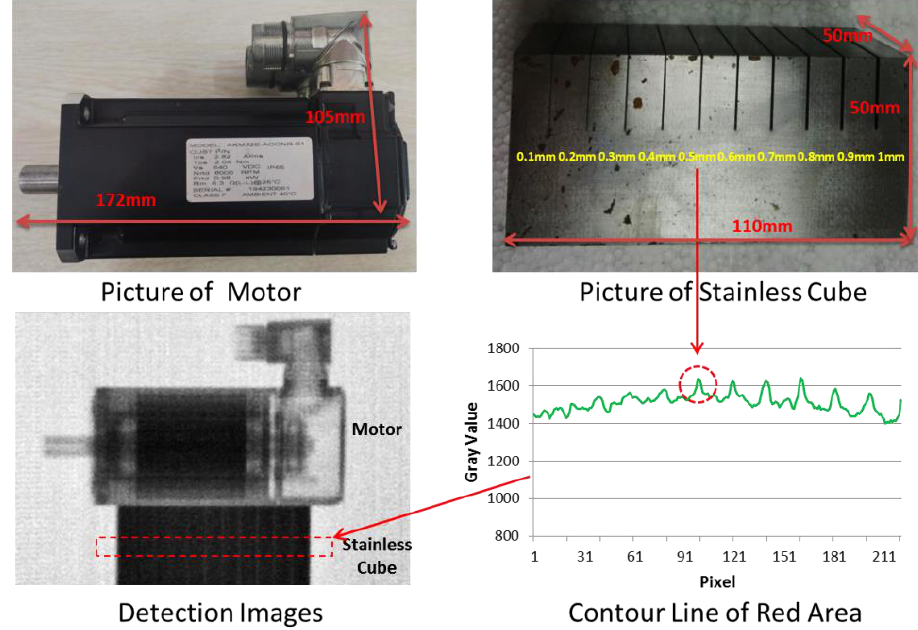
Figure 11. Preliminary scanning imaging results.